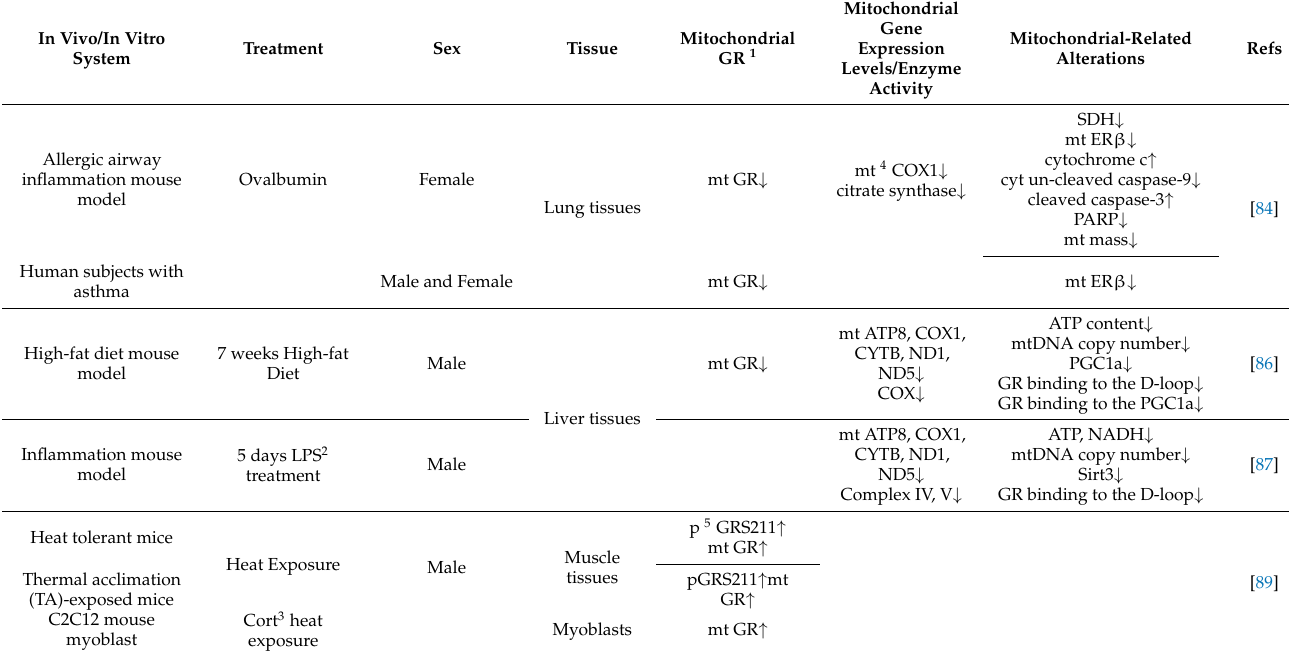
Table 5. Mitochondrial GR and mitochondrial-related alterations in lung disease, hepatic inflammation, and hyperthermia.